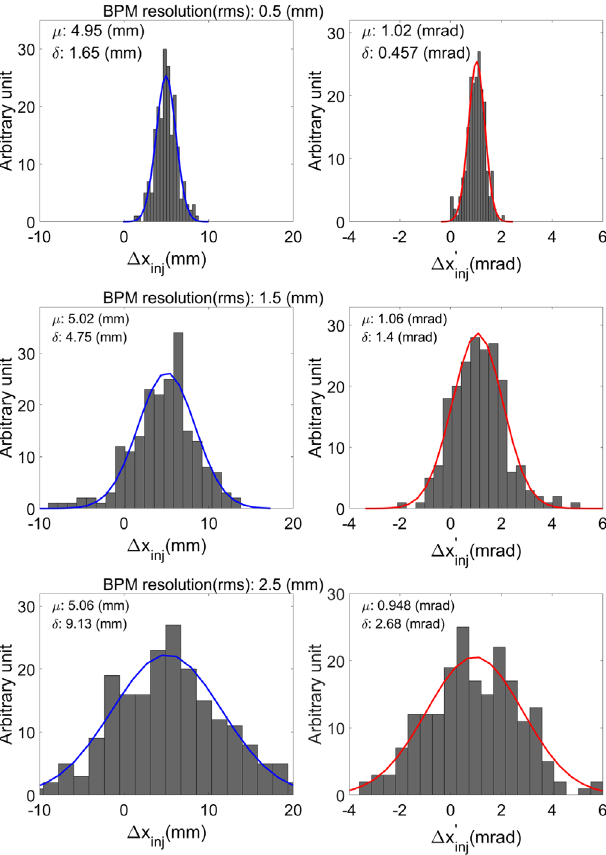
FIG. 4. Simulation results of reconstructing the phase space coordinates relative to the circulating orbit at the injection point, obtained by repeating calculations 200 times with the algorithm described in Sec. II A. In the simulations, the injection turn [ m in Eq. (2)] is 3, and the circulating turn [ n in Eq. (2)] is also 3. The left-hand plots are the position of the phase space coordinates, and the right-hand plots are the angular coordinates. The mean value ( μ ) and the width ( δ ) were obtained by fitting the distribution to a Gaussian function. The simulation results with a BPM resolution of 0.5, 1.5, and 2.5 mm are